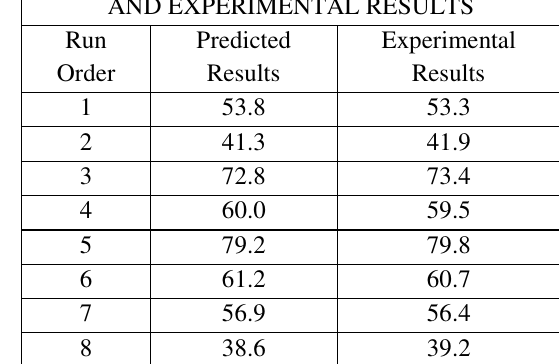
TABLE 4. COMPARISON IN PREDICTED